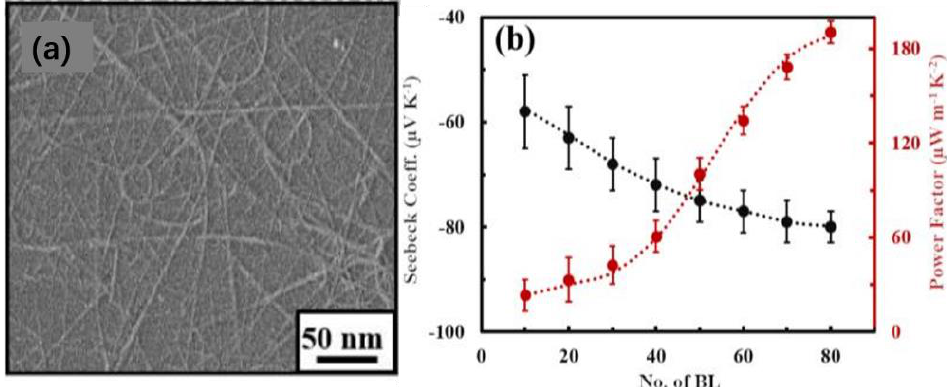
Figure 13. (a ) SEM surface image of two bilayers (BL) DWNT-PEI/graphene-polyvinylpyrrolidone (PVP) on Si wafer. ( b ) Seebeck coefficient and power factor of DWNT-PEI/graphene-PVP. Copyright © 2021 Elsevier B.V.